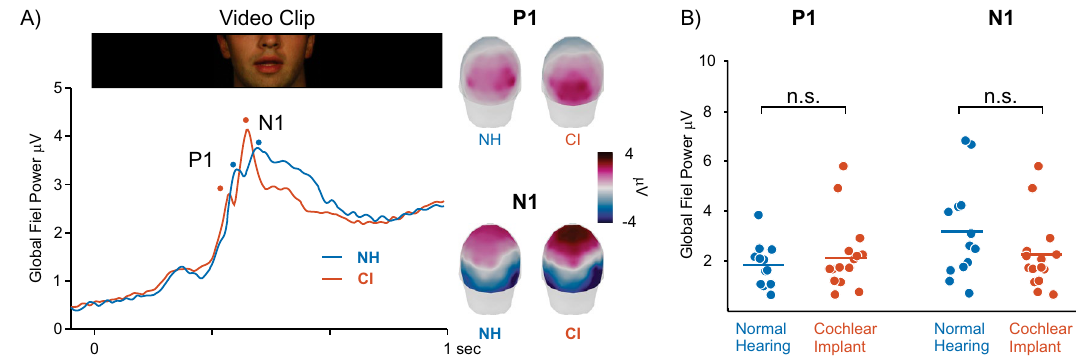
Figure 1. EEG sensor results. ( A ) Grand average EEG global field power during the lipreading video clip for NH (blue) and CI (red) groups. The video clip began at 0 s and ended at 2.5 s as bounded by the still image from an example clip above the time series. The topographic plots in the right side of panel A are from a posterior view and show voltage distributions at the P1 and N1 GFP peaks for both groups. ( B ) NH and CI group differences in GFP at P1 and N1 peaks. Each dot represents a participant. For all scatterplots, colored horizontal lines reflect group means.